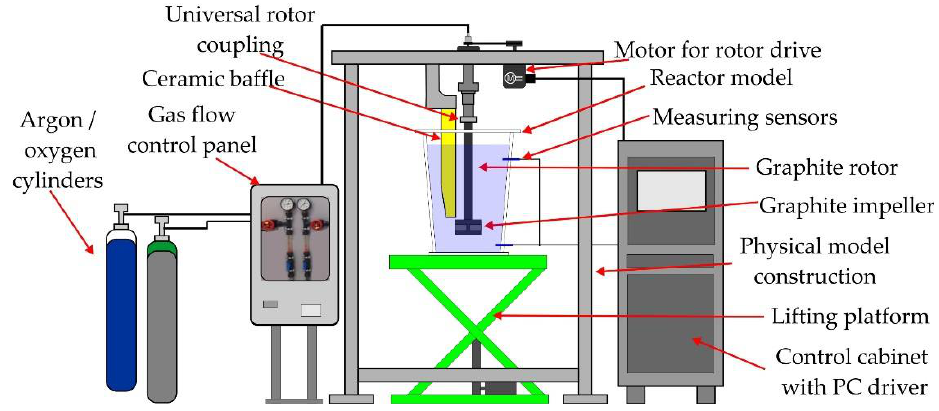
Figure 1. Schematic diagram of the FDU physical (water) model.